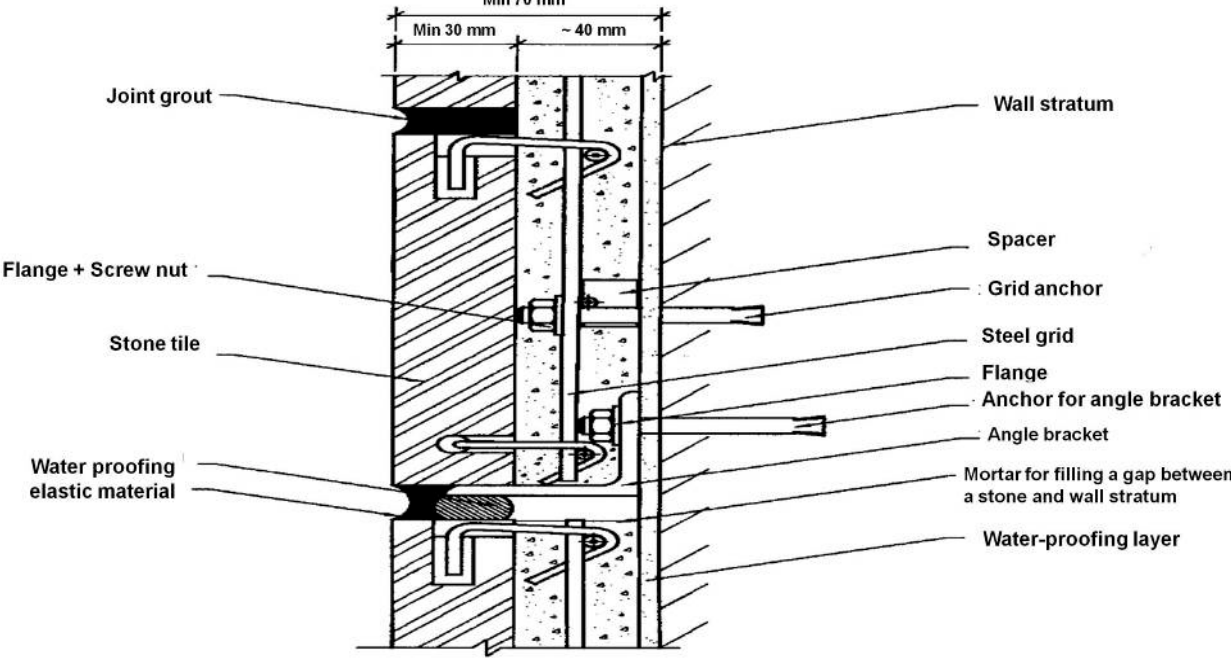
Figure 4. Design of stone veneer, according to [11].